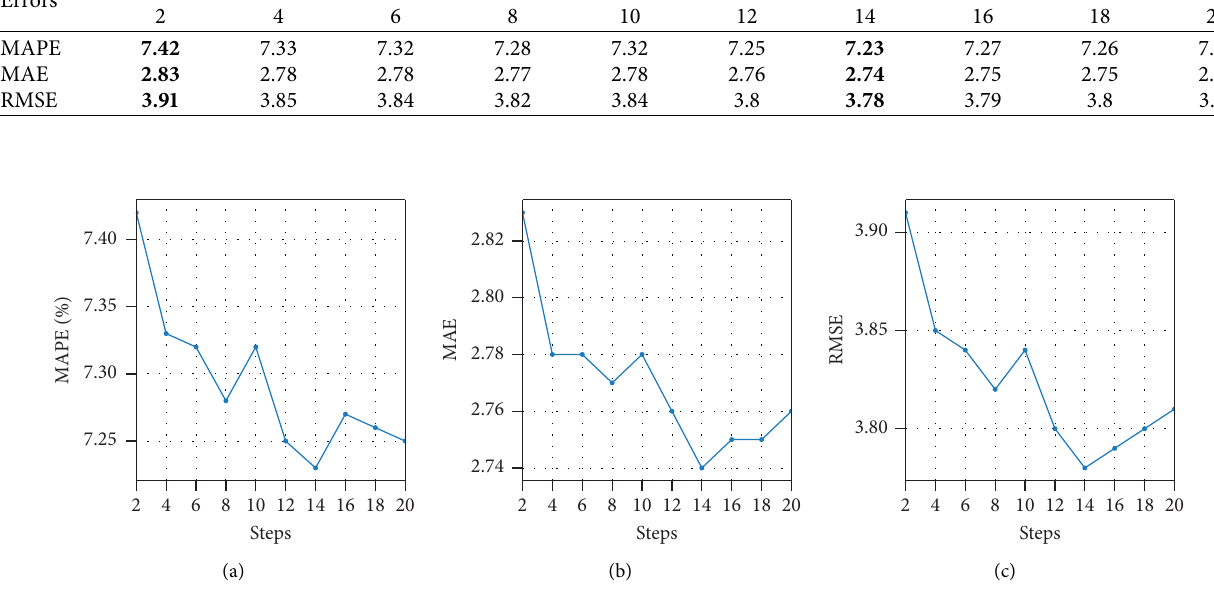
Figure 4: Prediction errors of the LSTM model with different backtracking steps on detector 16,395. (a) MAPE. (b) MAE. (c) RMSE.